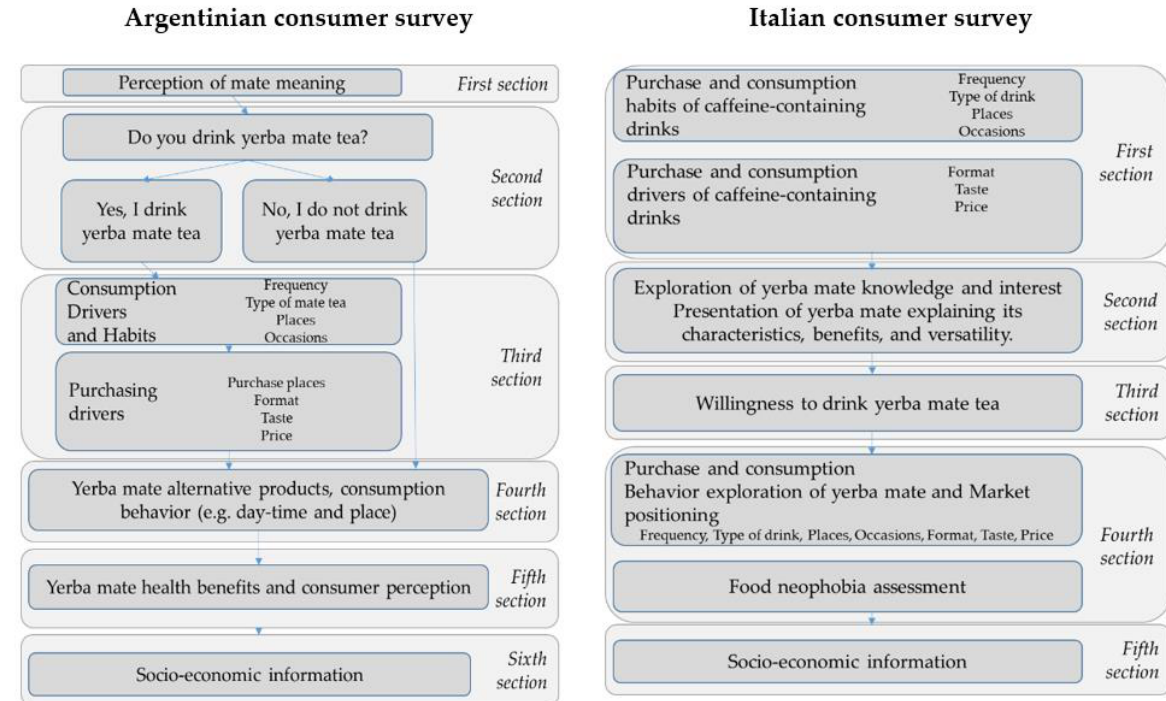
Figure 7. Questionnaire data collection structure and content.